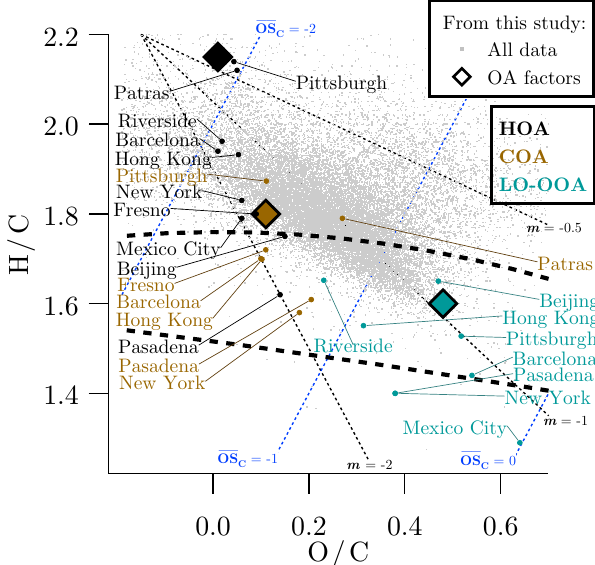
Figure 10. The Van Krevelen plane. Gray points represent all OA measurements in this study. Diamonds represent OA factors identi- fied in this study. For reference, the placement of OA factors from other ambient measurements is shown: Pittsburgh (Gu et al., 2018), Patras, Greece (Kaltsonoudis et al., 2017), Riverside, CA (Docherty et al., 2011), Barcelona (Mohr et al., 2012), Hong Kong (Lee et al., 2015), New York, NY (Sun et al., 2011), Fresno, CA (Ge et al., 2012), Mexico City (Decarlo et al., 2010), Beijing (Hu et al., 2016), and Pasadena, CA (Hayes et al., 2013). Different oxygenation path- ways are shown by the black dotted lines. Dotted blue lines are iso- pleths for average carbon oxidation states (OS C = 2 × O / C − H / C). The region of ambient oxygenated OA measurements, as reported by Ng et al. (2011), is shown between the dashed curves.